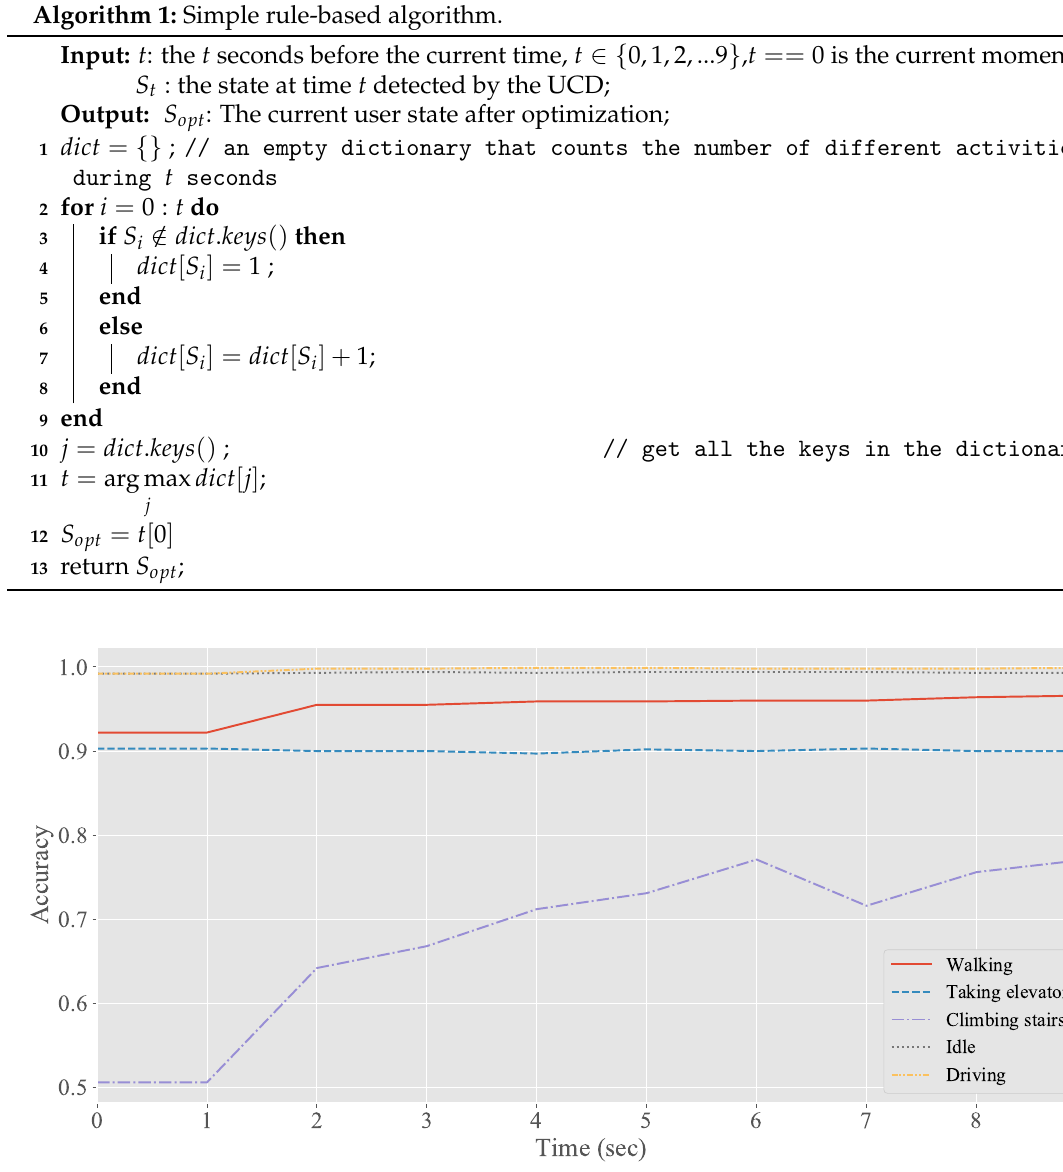
Figure 8. Detection performance for long-time activity after optimization using the simple rule-based